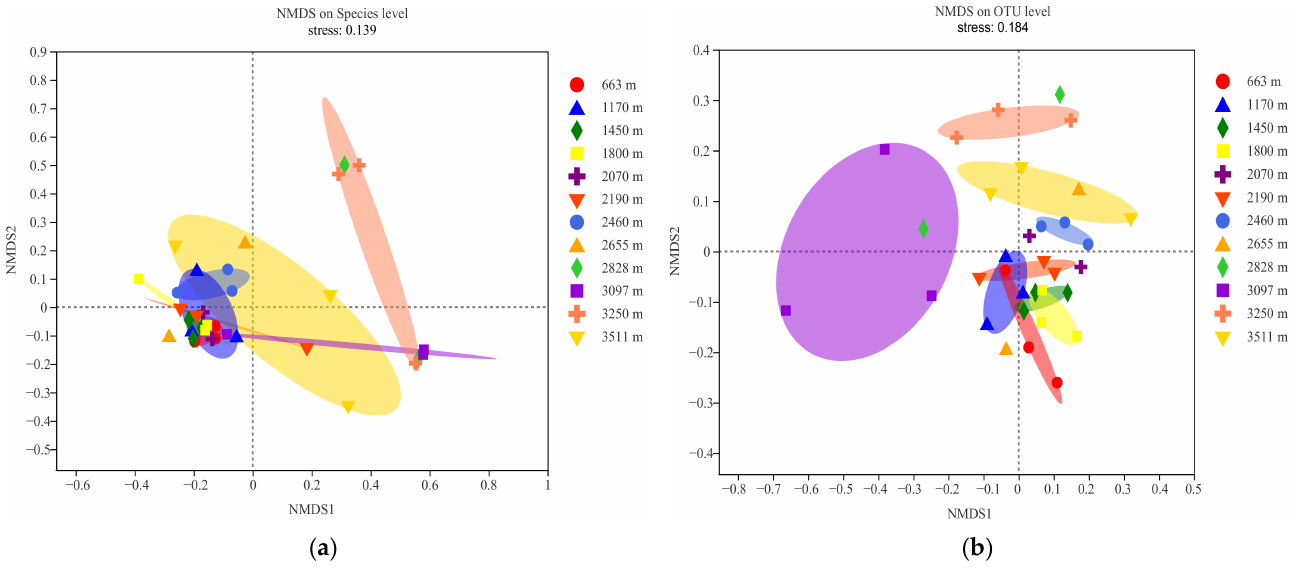
Figure 4. Nonmetric multidimensional scaling (NMDS) ordination of symbiosis AMF community composition of plant roots at different altitudes in Mt. Taibai (( a , b ) stands for the species and OTU levels, respectively).